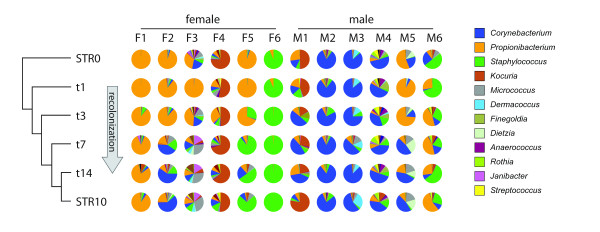
Recolonization after stripping. The tree-like structure in the left side of the figure is the consensus tree. It was generated using consense (Phylip_REF) of the per-volunteer UPGMA UniFrac trees of the samples. The pie charts show the microbial community composition of the individual samples. Composition is displayed as relative abundance, that is, the number of reads assigned to a genus divided by the total number of reads assigned up to the genus level.